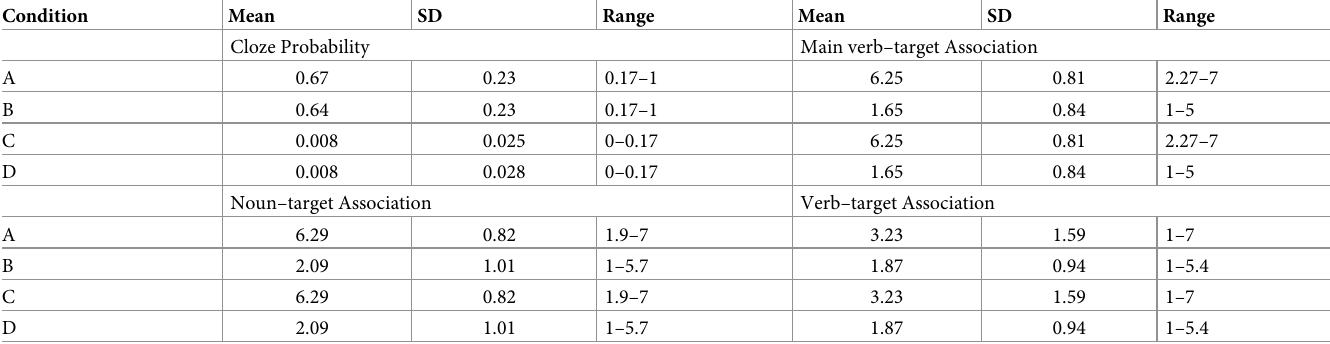
Table 2. Descriptive statistics. Descriptive statistics of the results of the Cloze (scale 0-1) and the association (scale 1-7) norming studies.